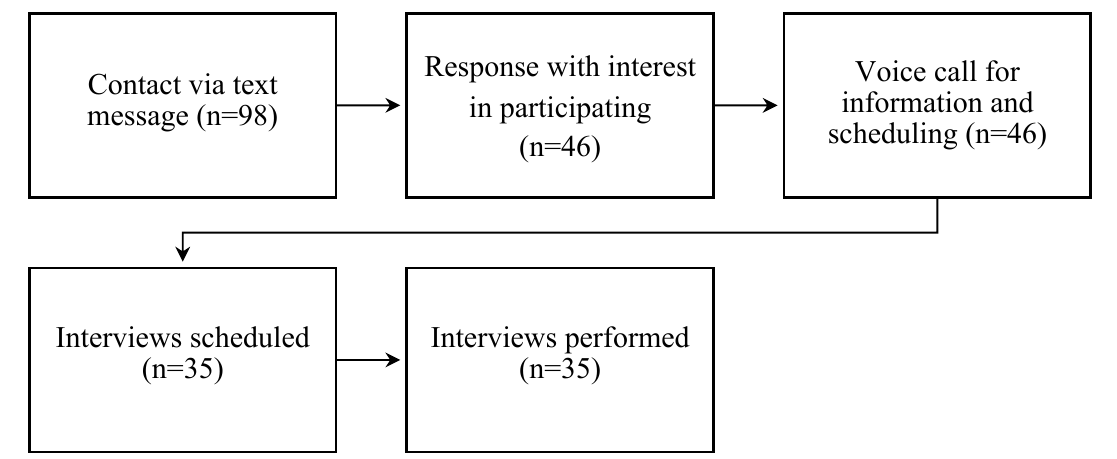
Figure 1. Flowchart of the recruitment process of the